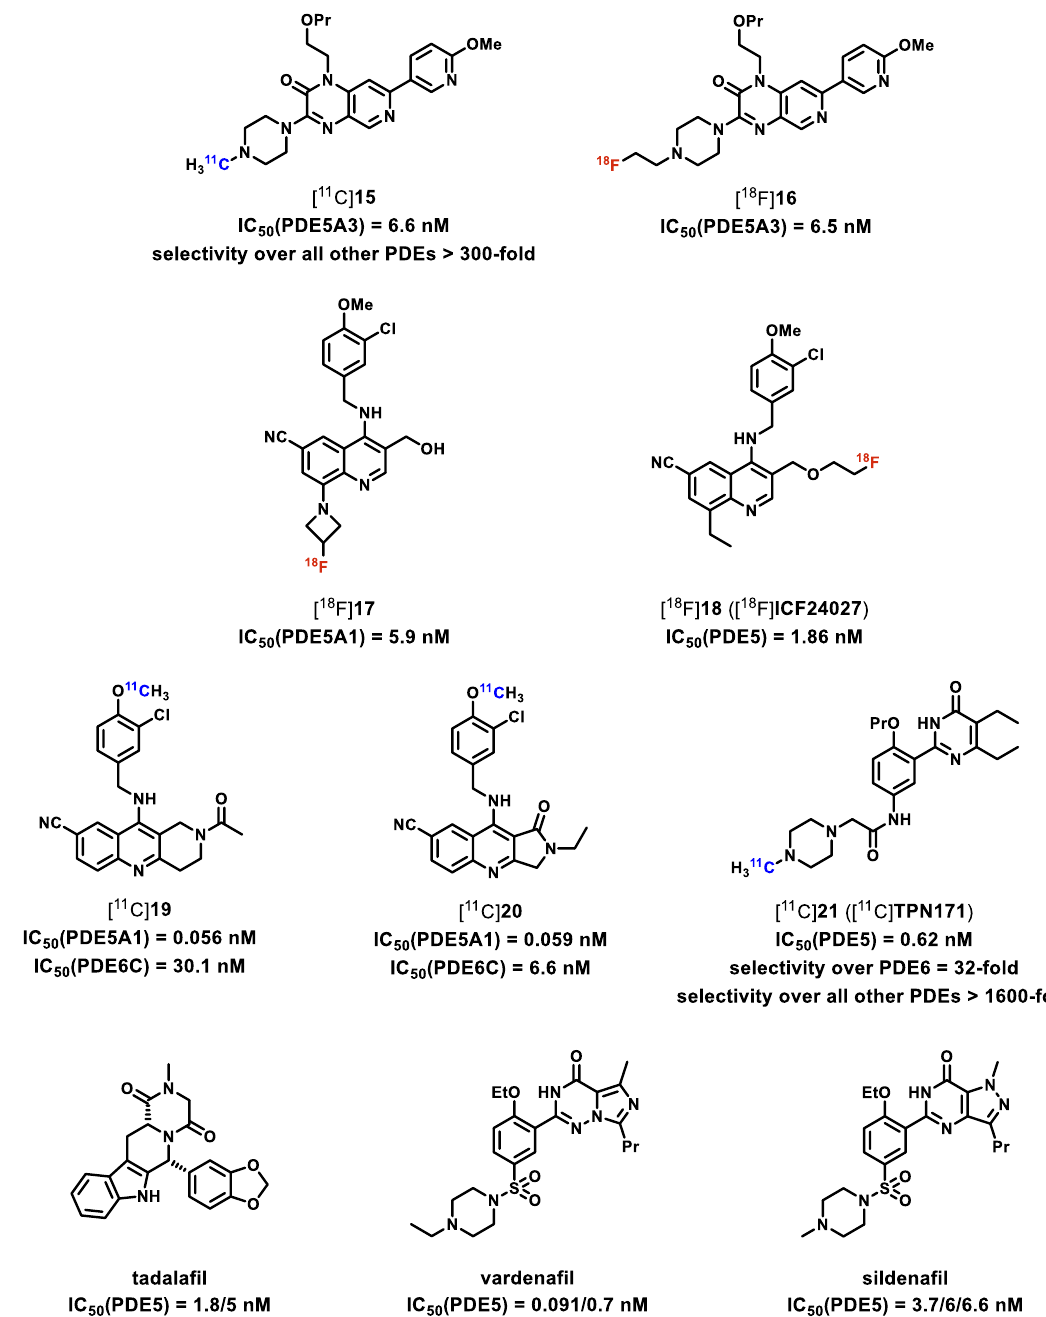
Figure 4. Molecular structures and IC 50 values for PDE5 of ([ 11 C]) 15 and ([ 18 F]) 16 [72], ([ 18 F]) 17 [73] and ([ 18 F]) 18 [74], ([ 11 C]) 19 and ([ 11 C]) 20 [75], ([ 11 C]) 21 [76,77]as well as the PDE5 inhibitors tadalafil [78,79], vardenafil [78,80] and sildenafil [78–80].